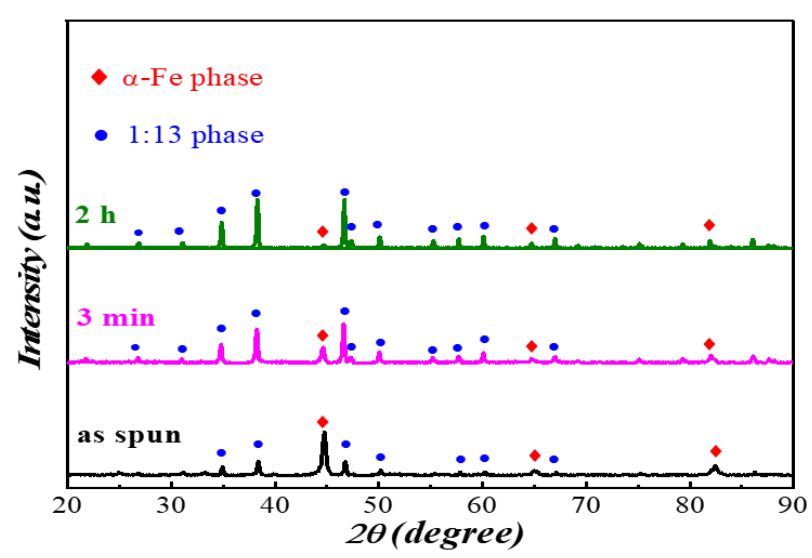
Figure 3. X-ray diffraction patterns of LaFe 11.5 Si 1.5 C 0.2 ribbons at a wheel speed of 35 m/s annealed at 1273 K for different times. Table 3. Lattice parameters of annealed LaFe 11.5 Si 1.5 C 0.2 ribbons at 1273 K for different